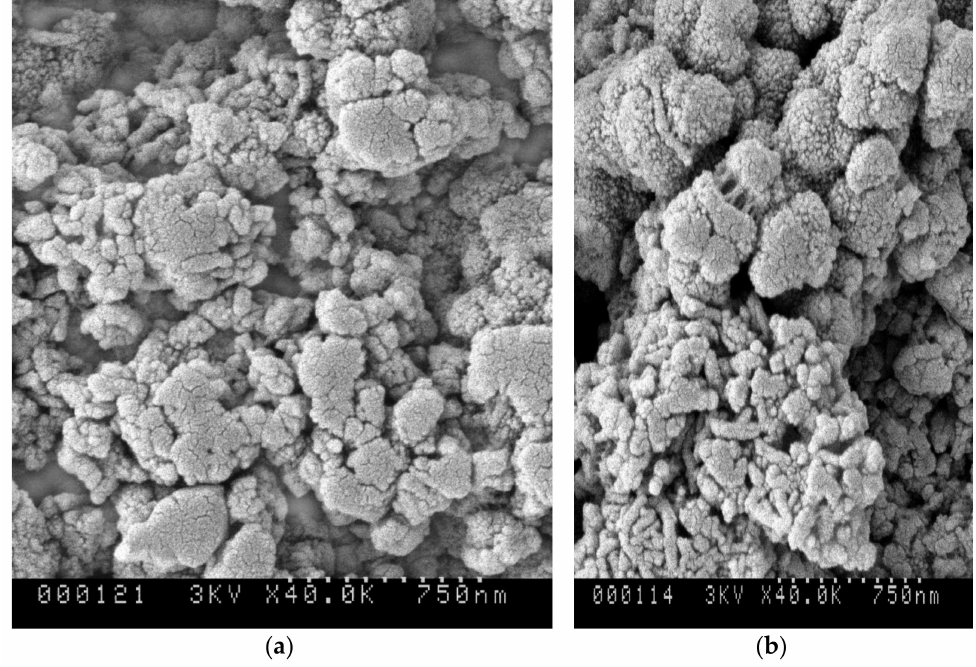
Figure 8. SEM micrographs of PANi –CSA ( a ) and PACN–CSA ( b